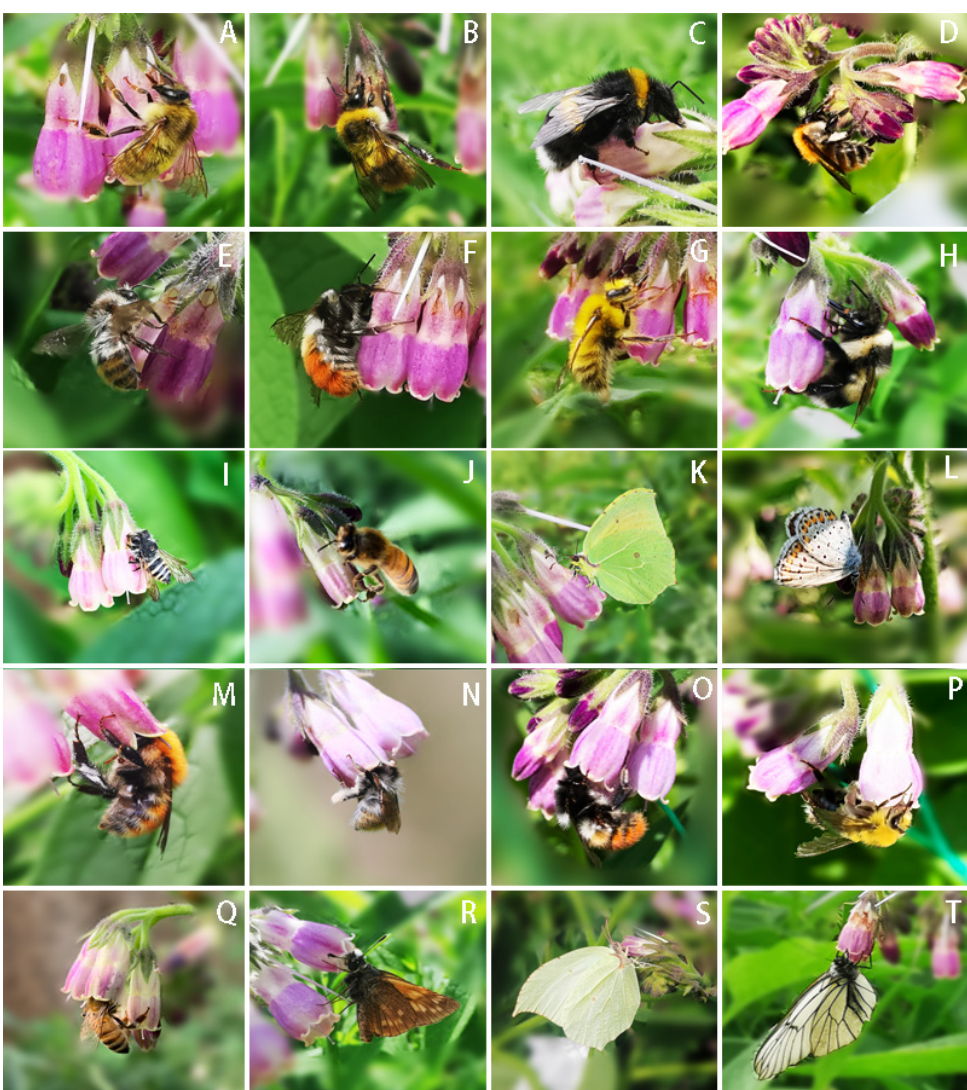
Figure 2. Visitors of S. officinale . ( A – L ): Illegitimately visit flowers (IV), gather nectar on base of corolla. M–T: Legitimately visit flowers (LV), gather nectar through the corolla entrance. ( A ) Bombus picipes , ( B ) Bombus longipennis , ( C ) Bombus lucorum , ( D , M ) Bombus hedini , ( E , N ) Bombus ladakhensis , ( F , O ) Bombus kashmirensis , ( G , P ) Bombus laesus , ( H ) Bombus lantschouensis , ( I ) Megachile rotundata , ( J , Q ) Apis mellifera , ( K , S ) Gonepteryx mahaguru , ( L ) Everes argiades , ( R ) Ochlodes subhyaline , ( T ) Aporia crataegi .